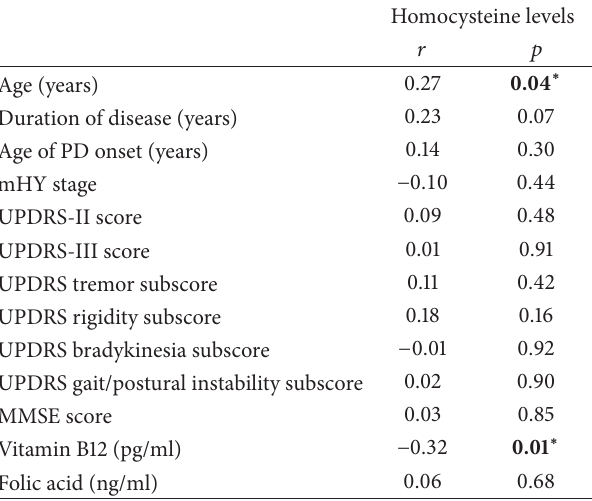
Table 2: Correlation between plasma homocysteine levels and demographic and clinical characteristics and serum B12 and folic acid